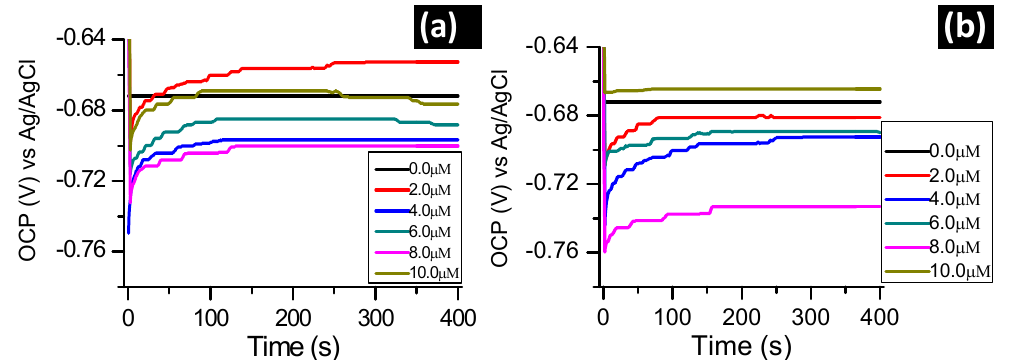
Figure 2. OCP evolution with time for aluminum in 1.0 M hydrochloric acid in the absence and presence of ( a ) BTThio and ( b) ClGaBTThioPc.